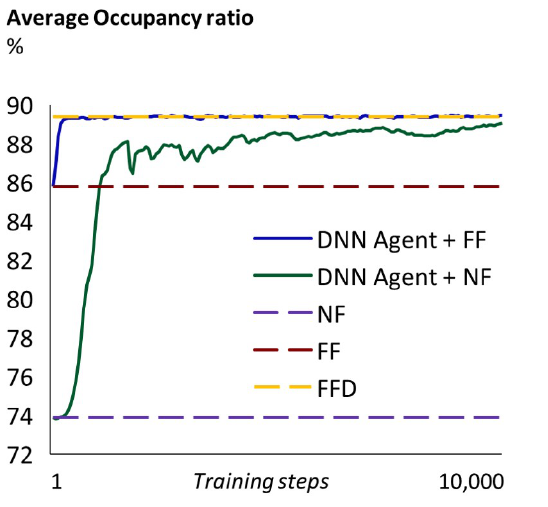
Figure 10. Training history. Problem 2: batch average occupancy ratio (%) after each training step, compared to the average occupation ratio obtained using the NF, FF and FFD heuristics.